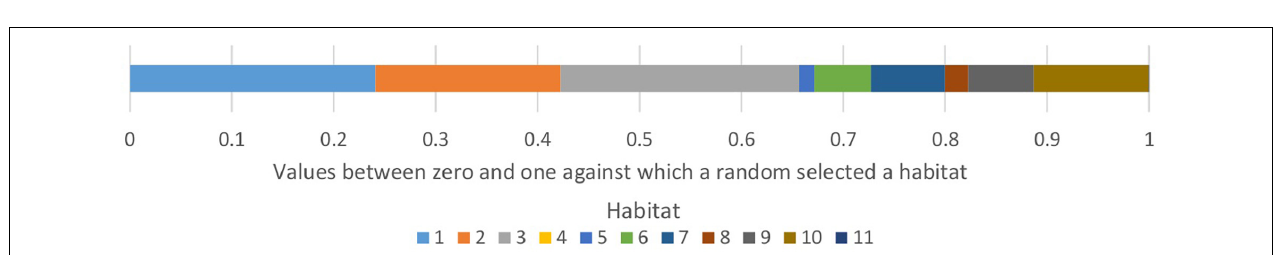
FIGURE 2 | Values used for the logistic slope within each scenario for habitat-biased movement and mortality. The graph shows the effect the slopes have on the multiplying values used to bias the movement toward more suitable habitat and to increase mortality in less suitable habitat. There is mortality due density-dependence and from being over the carrying capacity of the whole simulation. The habitat-modified mortality is additional mortality above the normal levels. To link levels of additional mortality to that of the reproductive rate, the habitat mortality is multiplied by the reproduction rate 5 × 10 - 4 to give the additional amount of mortality. We used the same scenarios and values for 10 and 40% cover simulations. The specialist species were more competitive in more suitable habitats than the species in the habitat-dependency model and those more so than the generalists. Competitiveness was reversed in less suitable habitat.